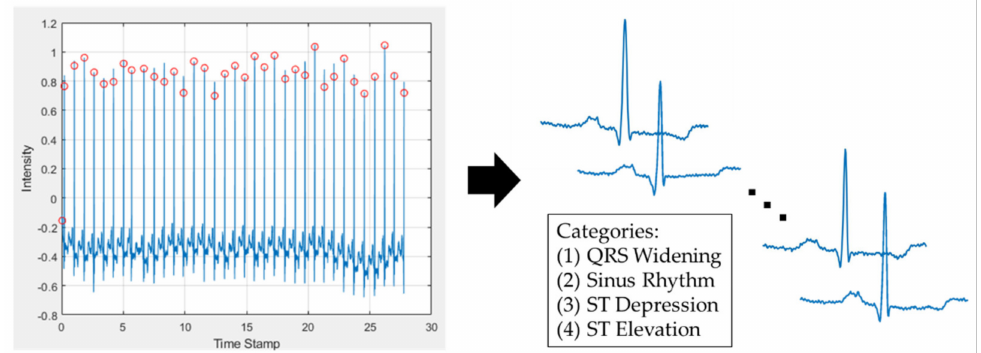
Figure 3. The pre-processing of the ECG signal. On the left is the input signal with automatically found peaks of the R wave. On the right is the segment of each period of the ECG wave. According to the MIT-BIH Arrhythmia Database, the four patterns of the signal of an ECG involved in this study include the sinus rhythm ( n = 19,751), QRS widening ( n = 21,377), ST depression ( n = 7163), and ST elevation ( n = 5899) (Figure 4). The four patterns of the ECG were made into 2D images, and these 2D images were used for building the convolution neural network (CNN) models. The classifier was split with fifty percent each as training and testing datasets. For example, the ST elevation signal had 5899 images. The training versus testing sets had 2950 and 2949 images, respectively. The classification model is trained by the training set and tested by the testing set. These models were created by pre-trained CNNs, which were ResNet [22], AlexNet [23], and SqueezeNet [24]. The numbers of 2D ECG images of the four patterns are shown in Table